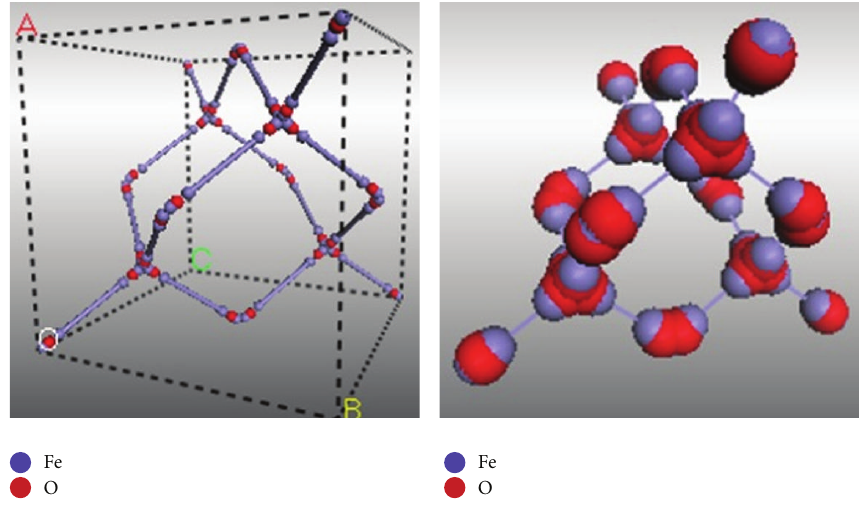
Figure 2: The polyhedral and ball models of magnetite crystal